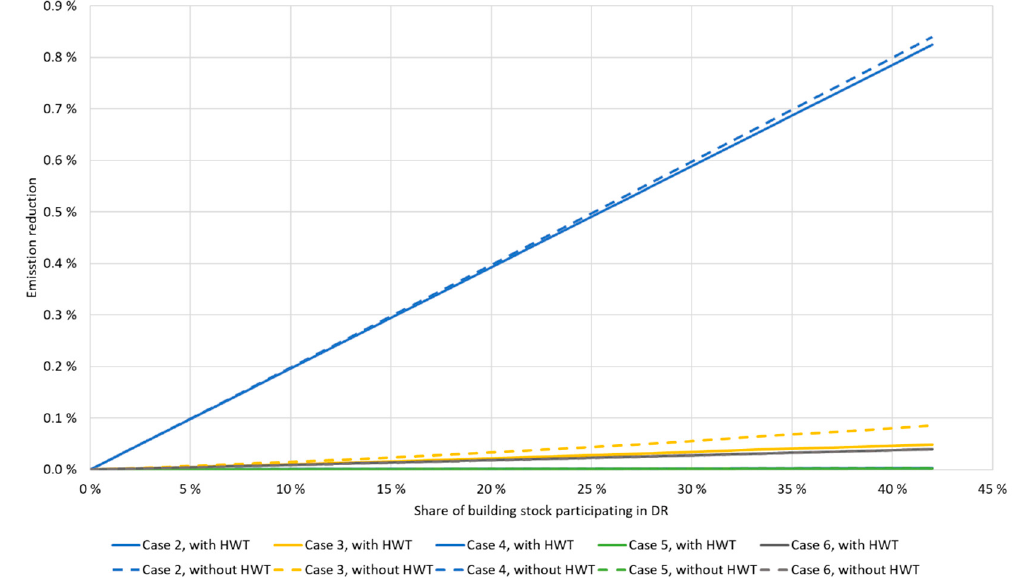
Figure 6. Emission reductions gained with the DR cases compared to the corresponding reference case.